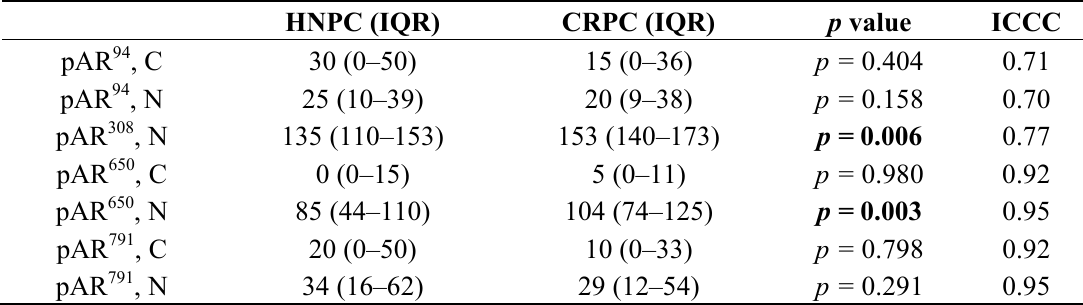
Table 2. Protein expression in hormone na ї ve and castrate resistant tumours: the median histoscore and interquartile range (IQR) for hormone na ї ve tumours (HNPC) and castrate resistant tumours (CRPC, tumours that have become refractory to hormone treatment) and the p value of these values compared using a Wilcoxon sign rank test. ICCC = interclass correlation coefficient. C and N relates to protein cellular location, C (cytoplasm) and N (nucleus). p before a protein indicates that the antibody detects phosphorylated protein and the number following the protein represents the serine site of